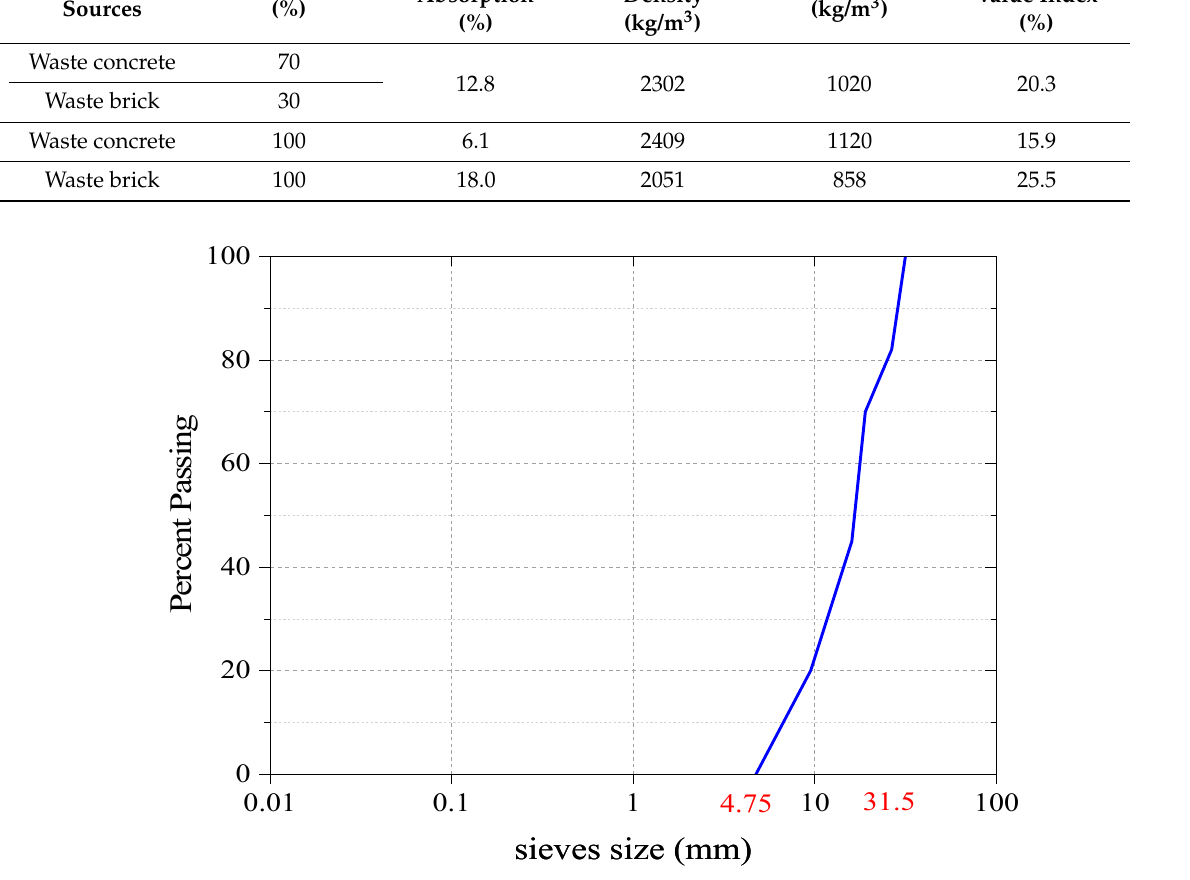
Figure 1. Grading chart of recycled aggregate.